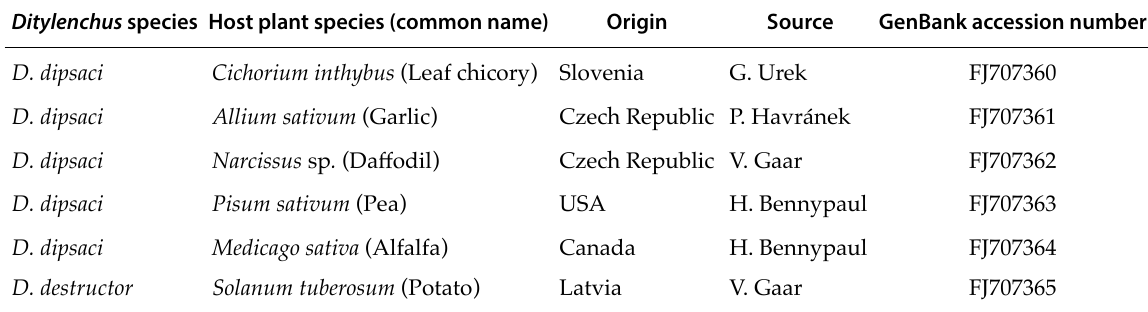
Table 1. Ditylenchus species sequenced in this study. Ditylenchus species Host plant species (common